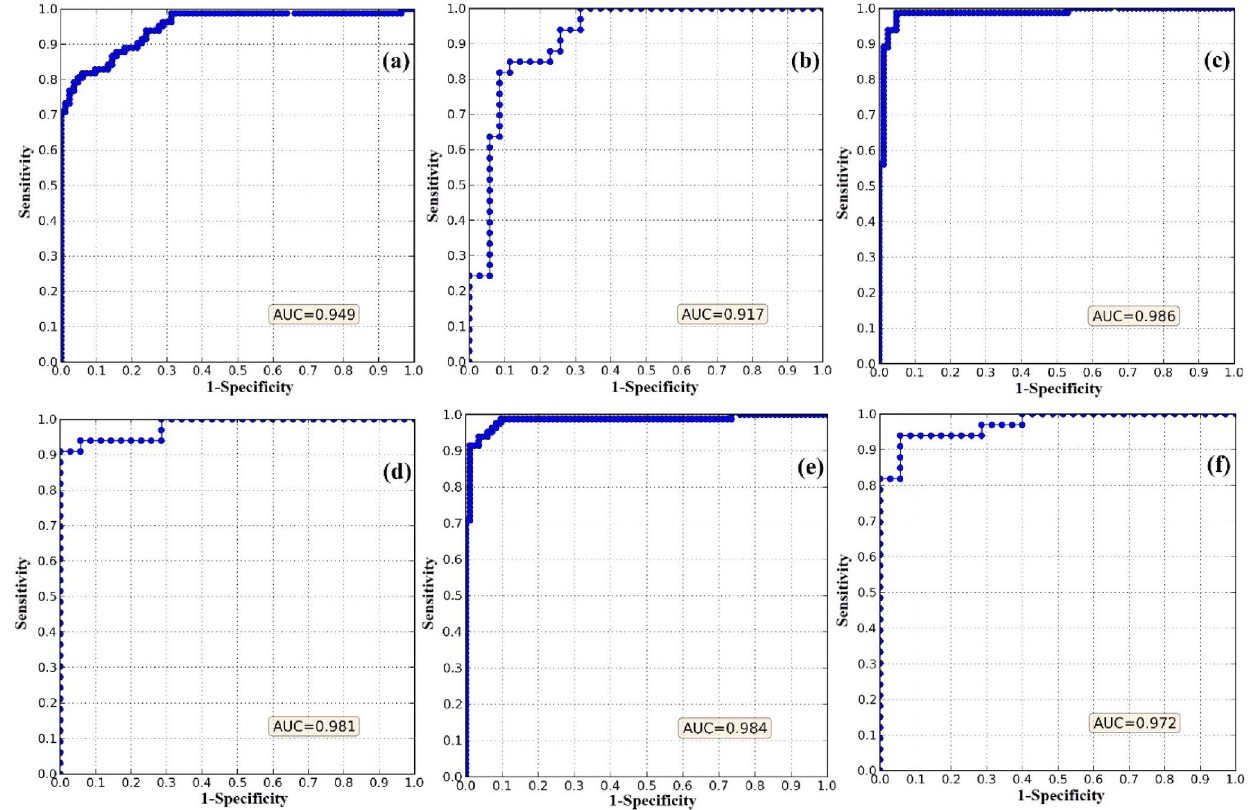
Figure 3. Goodness-of-fit and predictive performance of models based on the AUC metric: ( a ) SVR in training, ( b ) SVR in validation, ( c ) Wavelet-SVR-Bat in training, ( d ) Wavelet-SVR-Bat in validation, ( e ) Wavelet-SVR- GWO in training, and ( f ) Wavelet-SVR-GWO in validation.